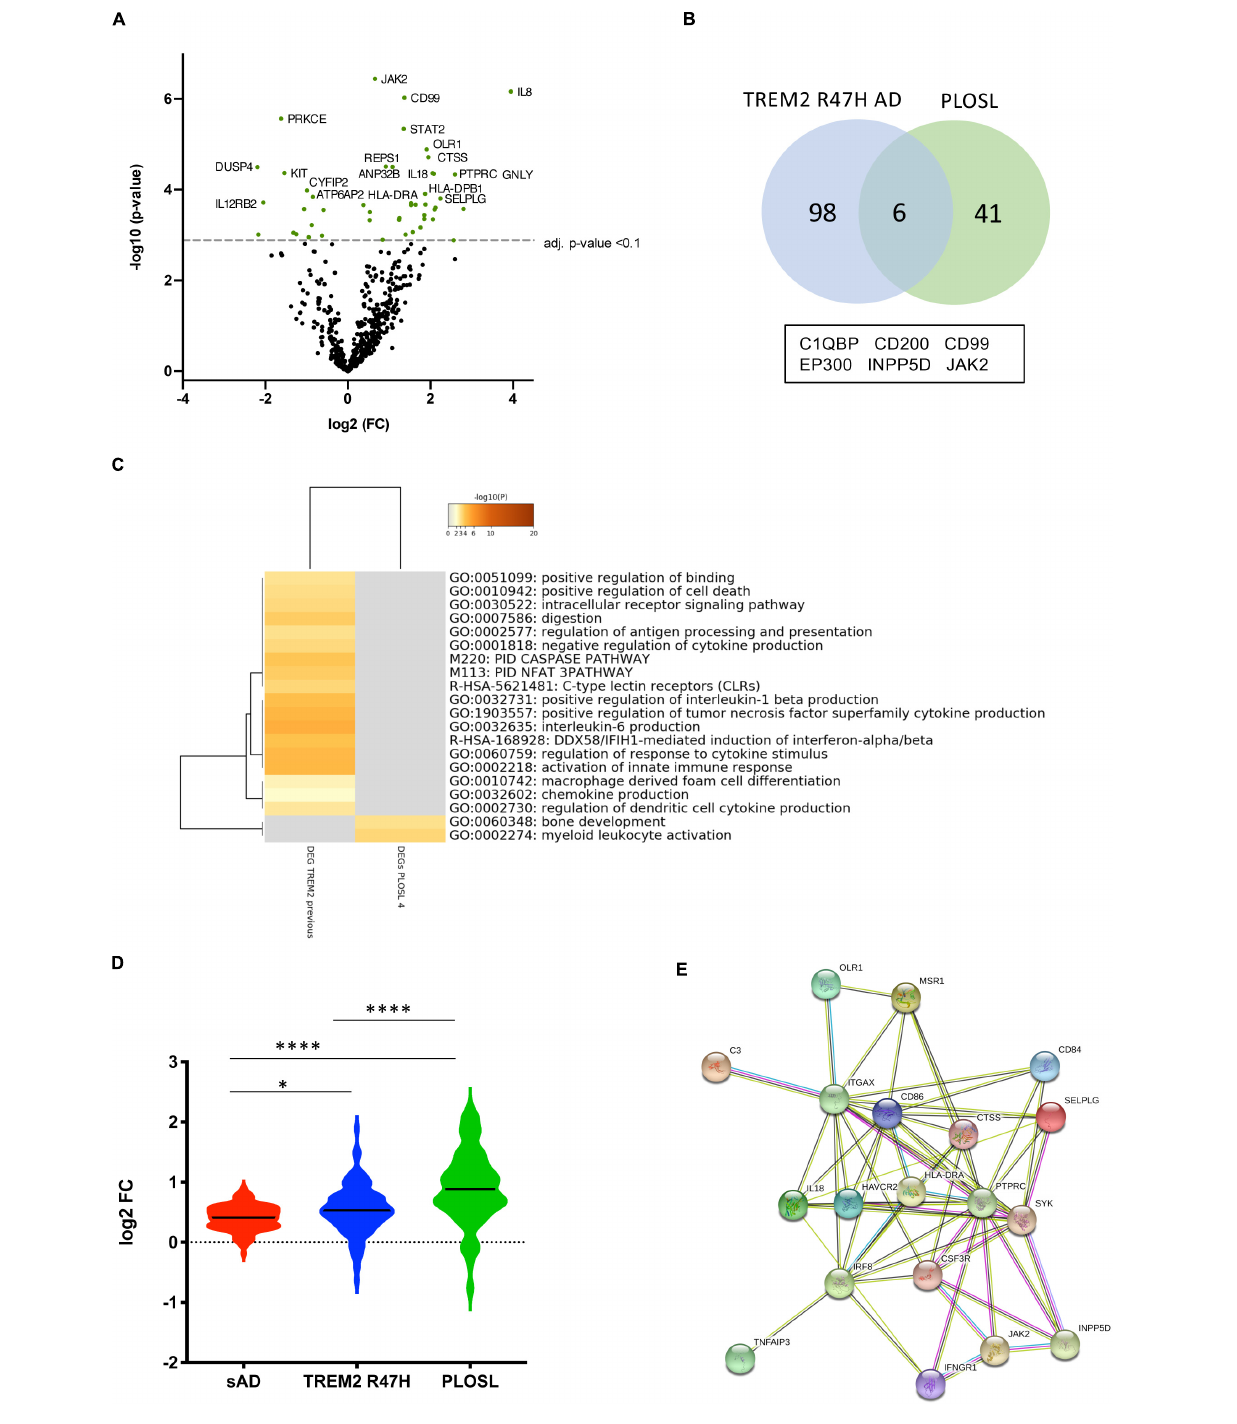
Frontiers in Immunology |